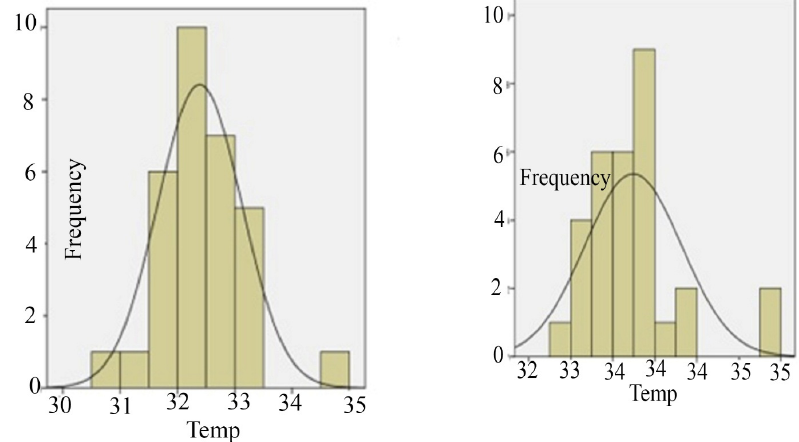
Figure 9. The frequency of the surface temperature of water in August 2008 ( Left ) and 2009 ( Right ).